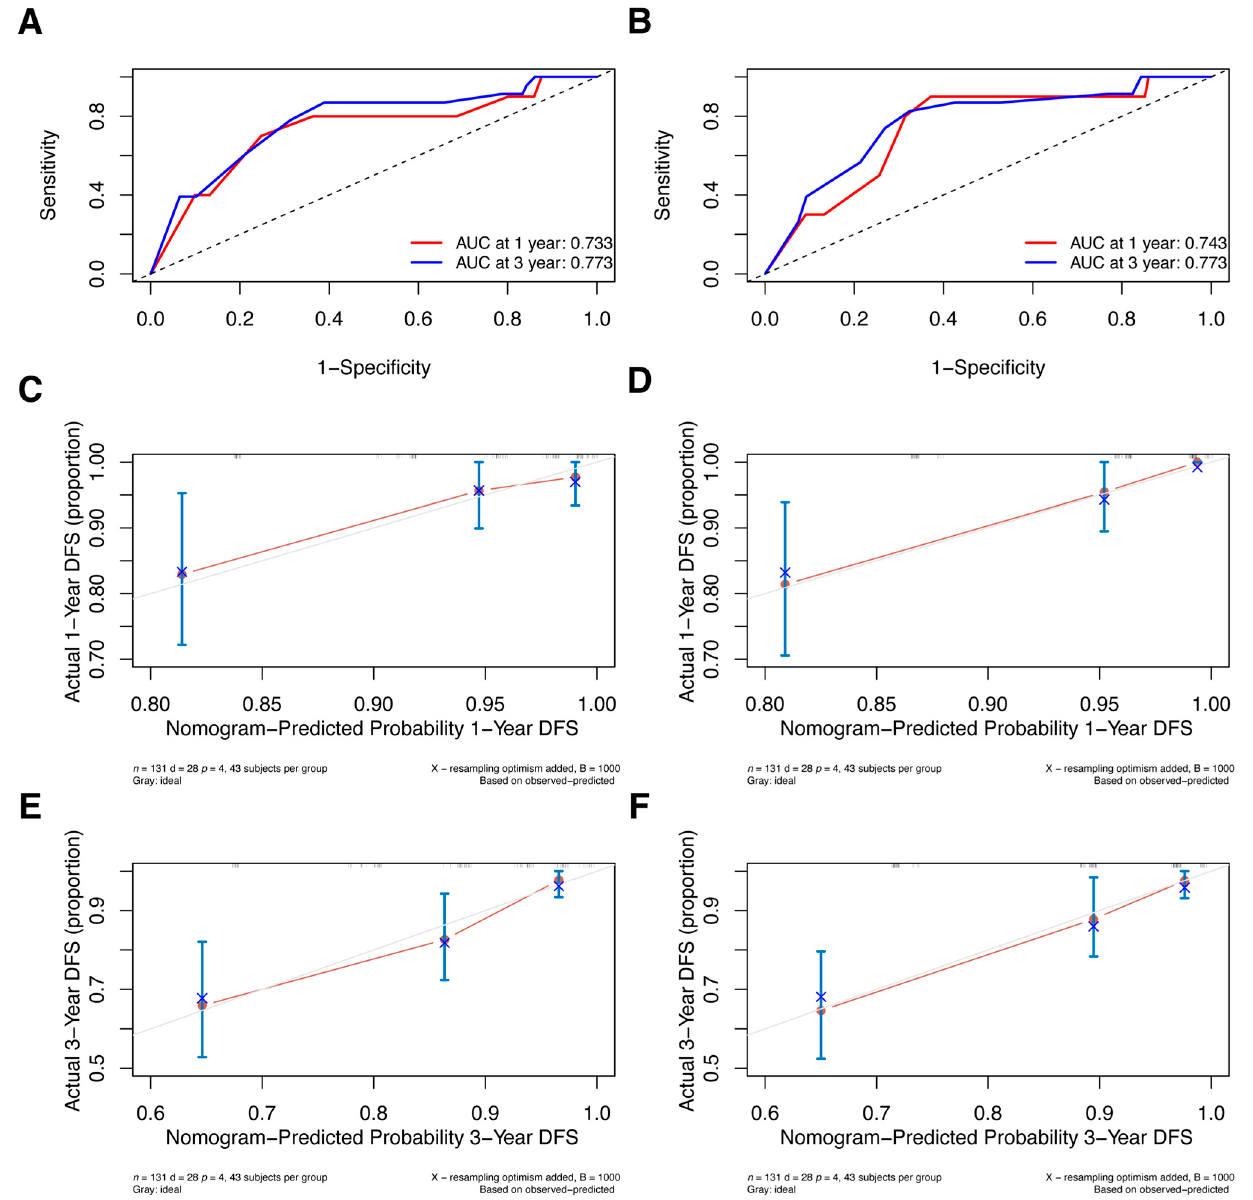
Figure 9. ROC curves for ( A ) the pre-NAC nomogram model and ( B ) the post-NAC nomogram model to predict the probability of 1- and 3-year DFS in the validation cohort. Calibration curves for the pre-NAC nomogram model predicting the probability of ( C ) 1- and ( E ) 3-year DFS in the validation cohort; calibration curves for the post-NAC nomogram model predicting the probability of ( D ) 1- and ( F ) 3-year DFS in the validation cohort. Dashed-line: reference line. Abbreviations: ROC, Receiver operating characteristic; NAC, neoadjuvant chemotherapy; DFS, disease-free survival; AUC, area under the curve.